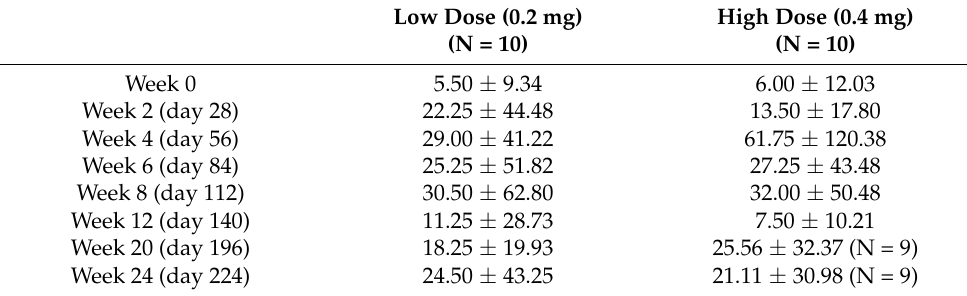
Table 5. Cellular response (IFN- γ ) to